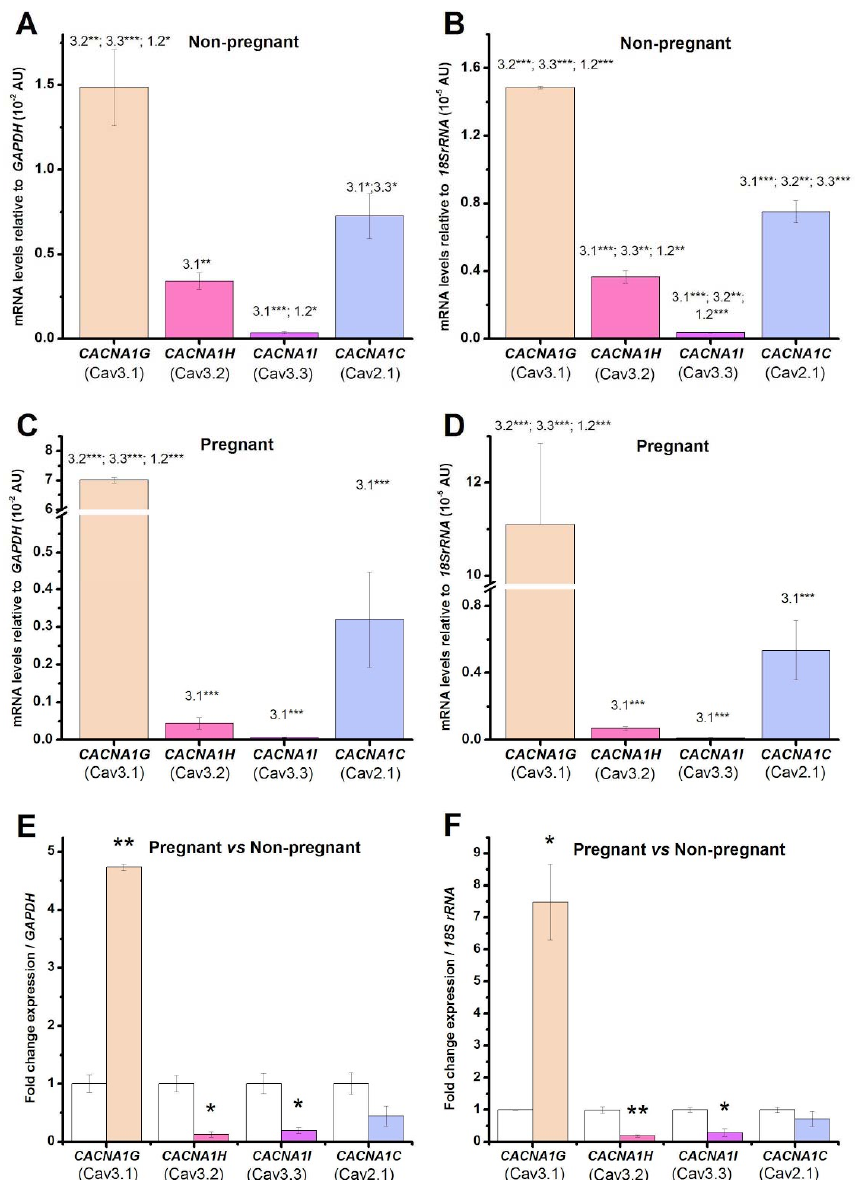
Figure 1. mRNA levels encoding the voltage ‐ gated calcium channels in human myometrial telocytes (TCs) from non ‐ pregnant ( A , B ) and pregnant ( C , D ) uterine samples. The mRNA levels for CACNA1G (Cav3.1 channel), CACNA1H (Cav3.2 channel), CACNA1I (Cav3.3 channel), and CACNA1C (Cav1.2 channel) were normalized against two different reference genes, GAPDH ( A , C ) and 18S rRNA ( B , D ), and were plotted as mean ± SD ( N = 3), corresponding to cell batches extracted from either pregnant or non ‐ pregnant uterine myometrium. One ‐ way ANOVA analysis, applied for the samples derived either from pregnant uterus or from non ‐ pregnant uterus, indicated: ( A ) F = 78, p < 0.001; ( B ) F = 545, p < 0.001; ( C ) F = 2580, p < 0.001; ( D ) F = 77, p < 0.001. The post ‐ hoc Bonferroni test was applied, and the statistically significant pairs are indicated by the numbers corresponding to the channels symbols, as follows: Cav3.1, 3.2, 3.3, and 1.2; ( E , F ) Fold ‐ change for each voltage ‐ gated calcium channel between non ‐ pregnant and pregnant uterine samples, where non ‐ pregnant samples were defined as calibrator, considering as housekeeping gene GAPDH ( E ) and 18S rRNA ( F ), respectively. Statistical significance is indicated with asterisks (* 0.01 < p < 0.05; ** 0.001 < p < 0.01; *** p < 0.001).